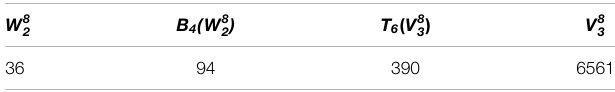
TABLE1| Degreesoffreedomforthefullspace W d g ofhomogeneouspolynomials of degree g (cid:1) 2, the TT variant B ρ ( W d g ) with maximal block size ρ max (cid:1) 4, the max space T r ( V d p ) with TT rank bounded by r (cid:1) 6, and the full space V d p for completeness.